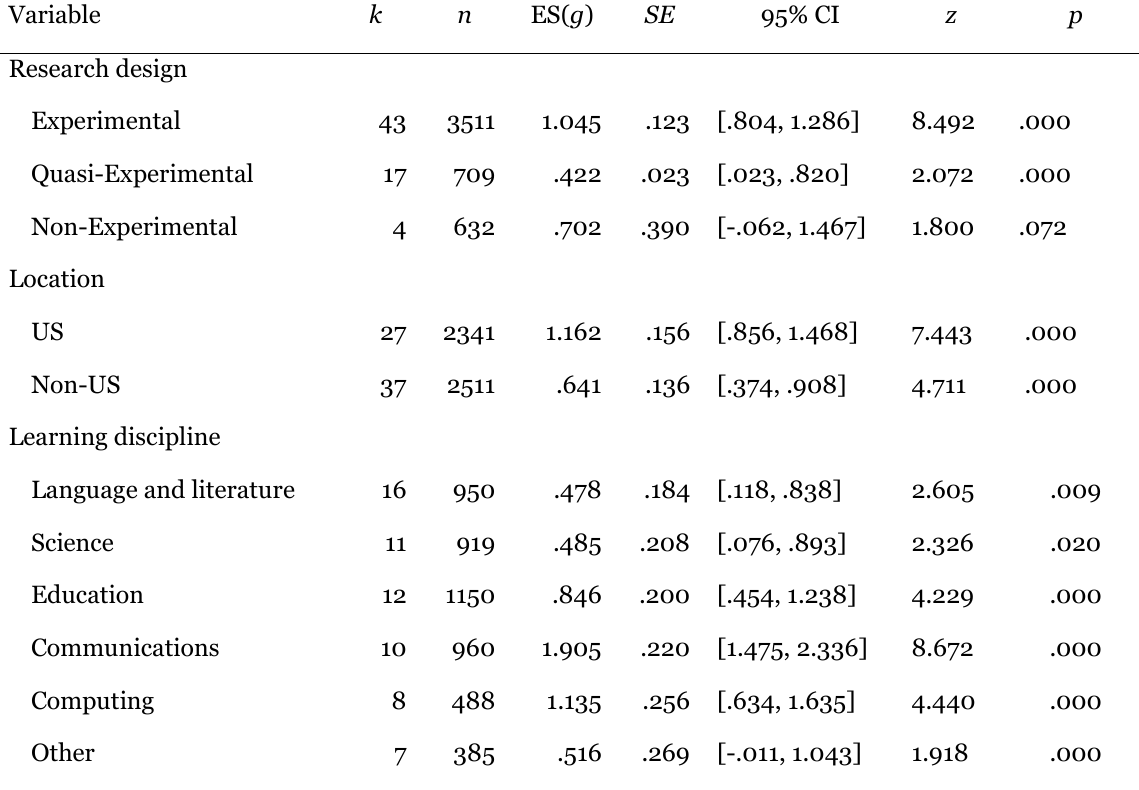
Effect Sizes of Learning Outcomes: Research Design, Location, and Learning Discipline